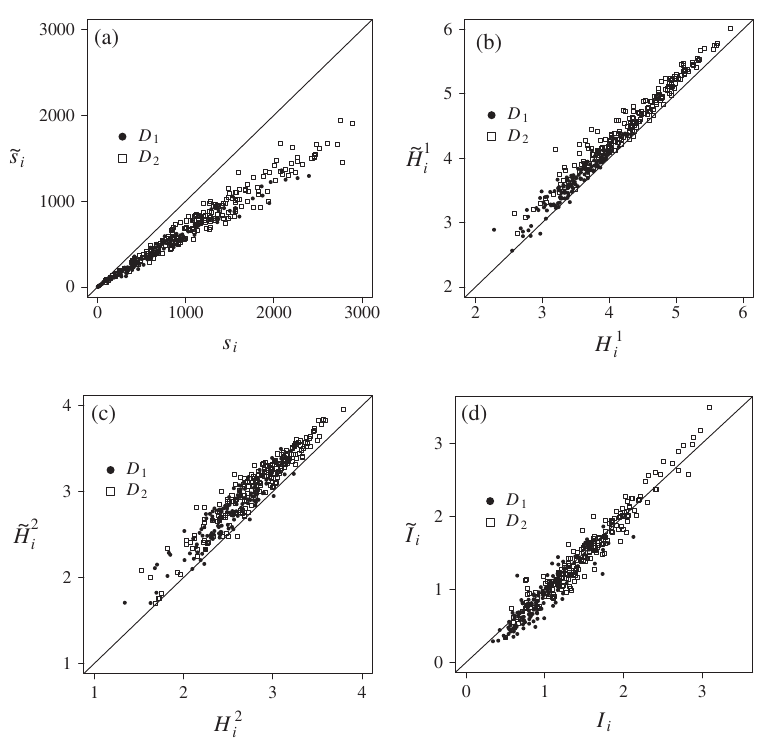
FIG. 18. Comparison between the interpolated and original data for data sets D (c) conditional entropy, and (d) mutual information for the interpolated data with m ¼ 5 are plotted against those without interpolation (i.e., original data